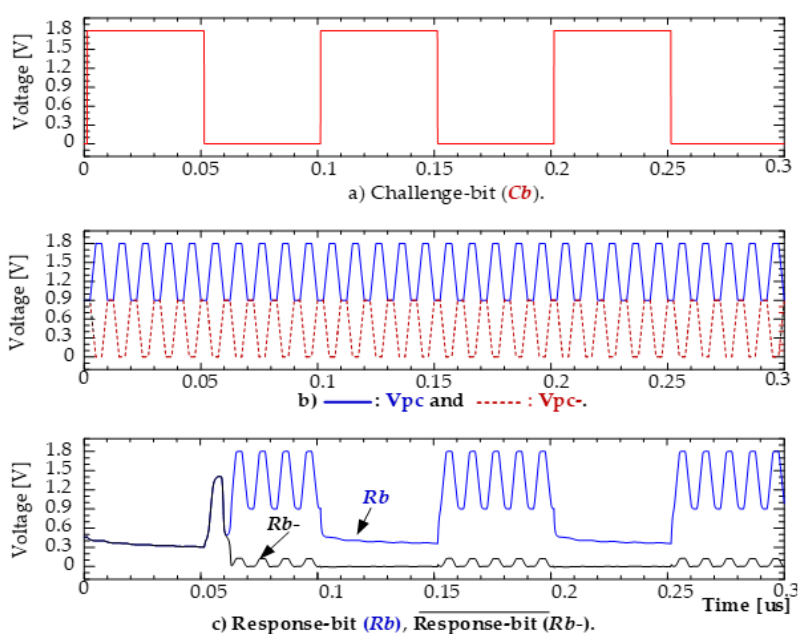
Figure 7. Input and output signals of the proposed adiabatic PUF.